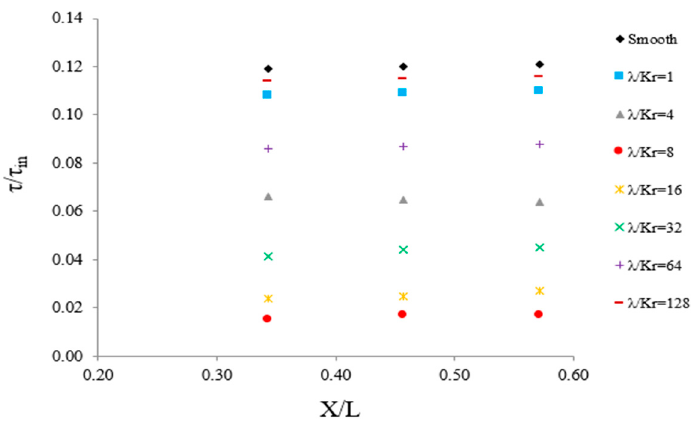
Figure 9. Bottom shear stress for different bed configurations.